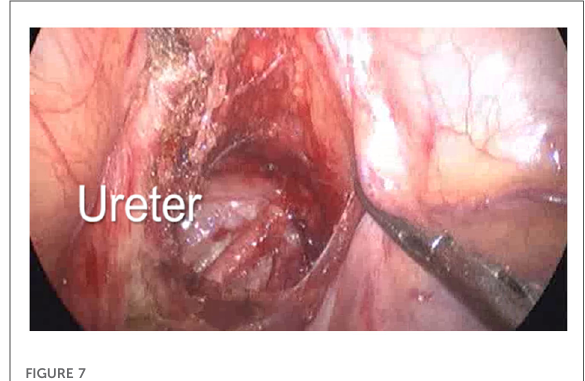
FIGURE 7 Clear identi fi cation of the pelvic